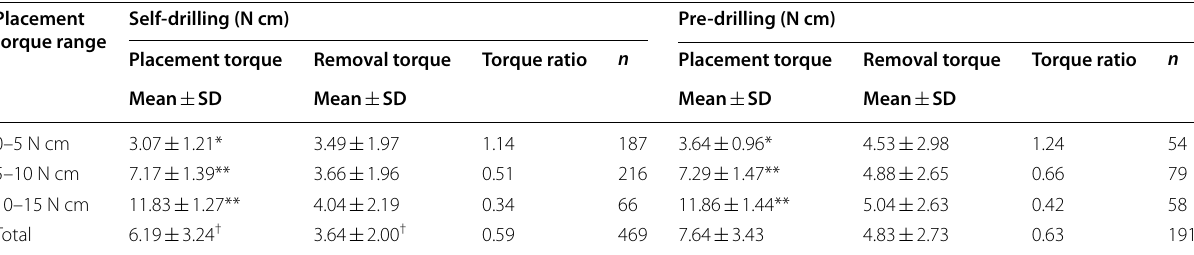
Paired t -test was performed for comparison between placement and removal torque. Independent t -test was performed for comparison between the self-drilling and pre-drilling methods *Significant difference at p < 0.05 between placement torque and removal torque **Significant difference at p < 0.001 between placement torque and removal torque † Significant difference at p < 0.001 between the self-drilling and pre-drilling methods